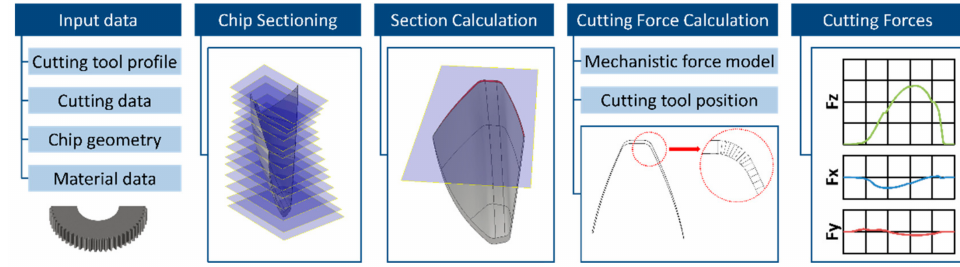
Figure 3. Cutting force calculation flowchart.